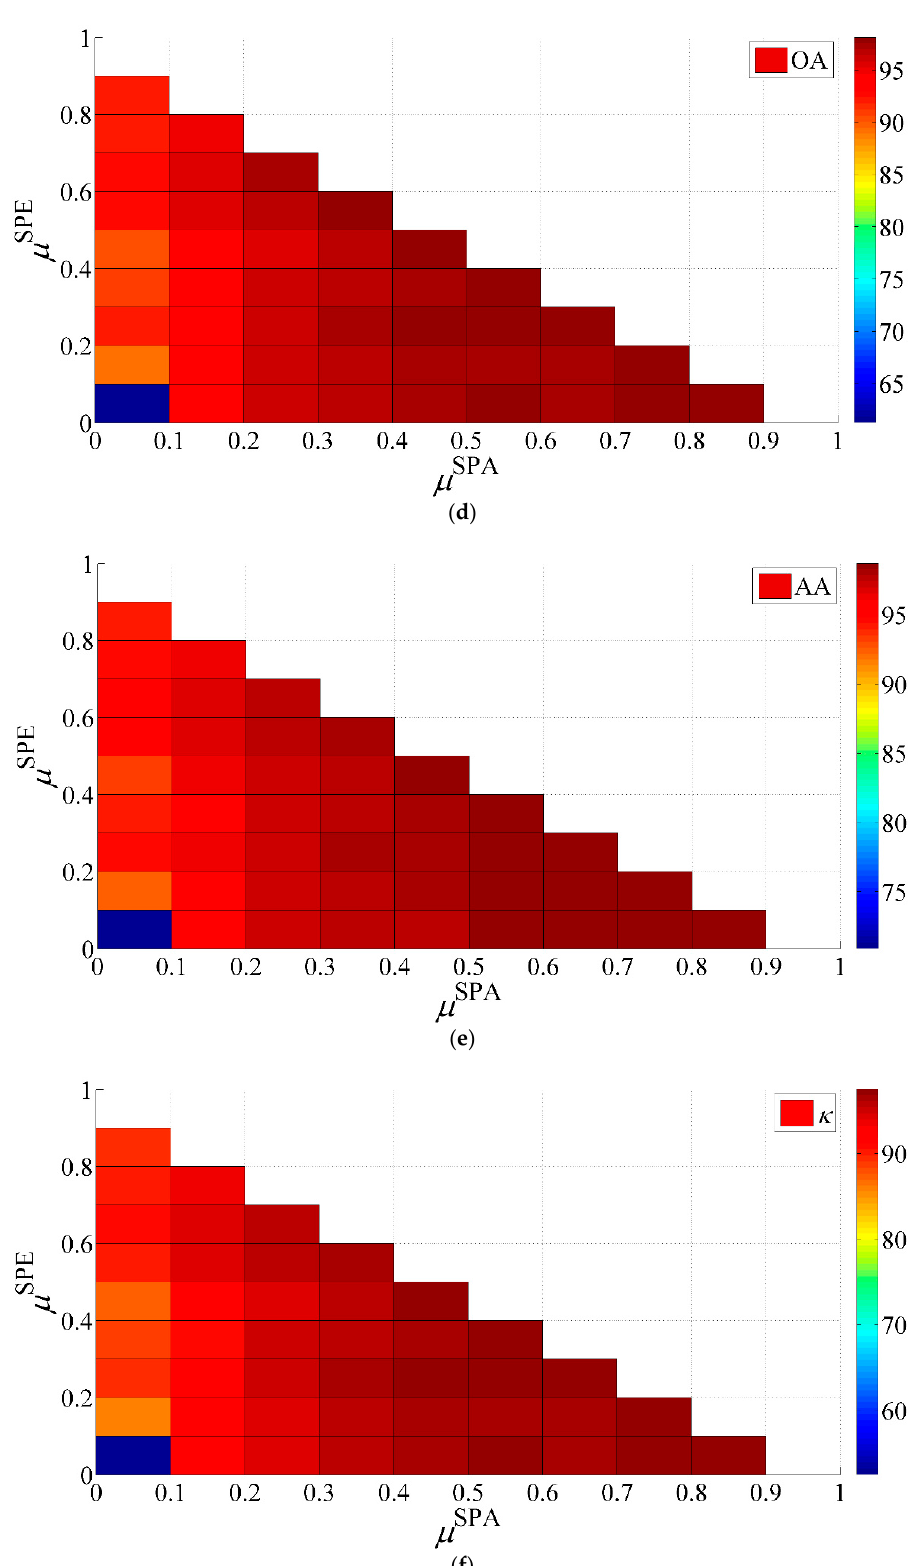
Figure 6. Impact of µ SPE and µ SPA using the two images on SVM-SSHK’s performance. ( a ) overall accuracy (OA); ( b ) average accuracy (AA); and, ( c ) kappa coefficient ( κ ) for the IP image; ( d ) OA; ( e ) AA and ( f ) κ for the UP image.